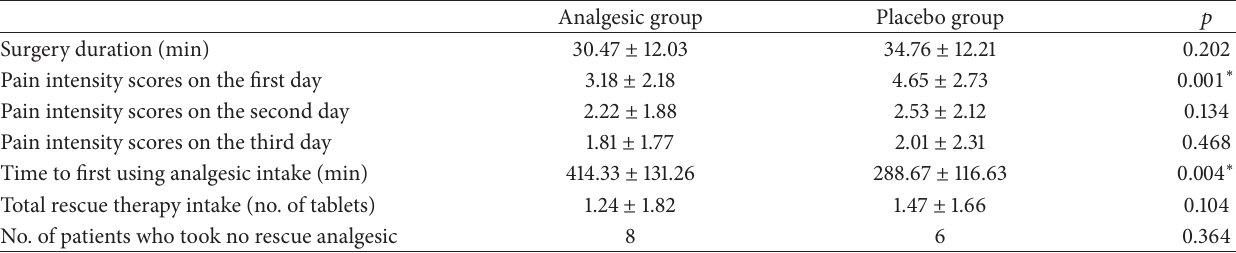
Table 1: Comparison of objective measurement data between the placebo and analgesic